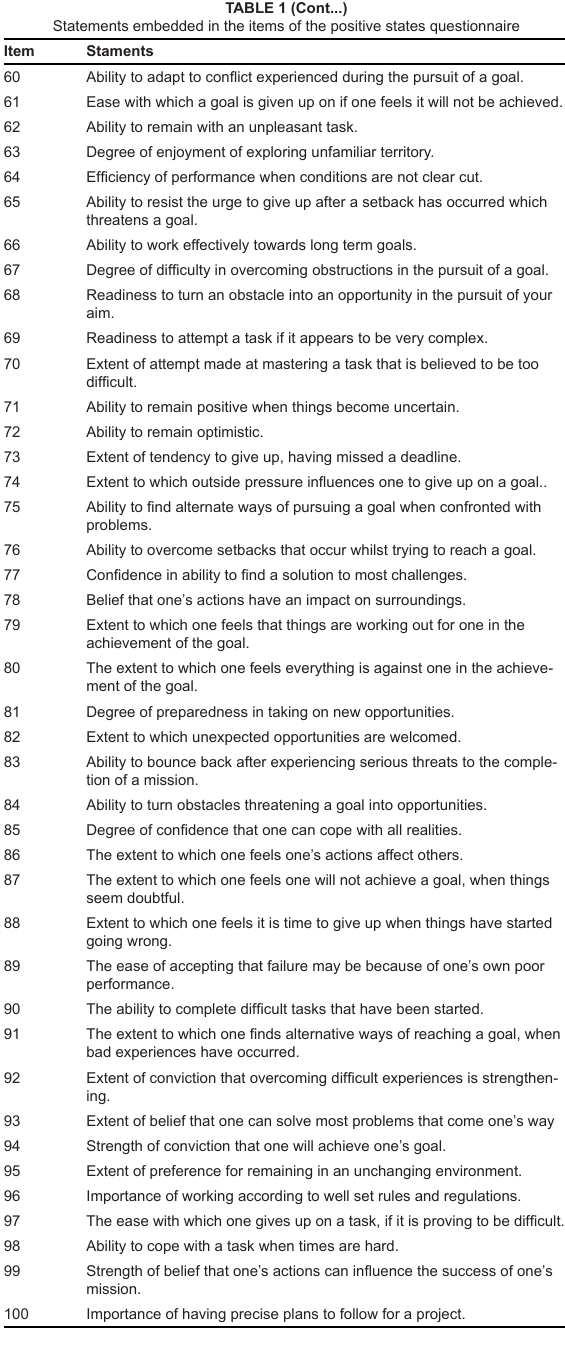
with the Cronbach alpha reliabilities ranging from 0.852 to 0.869. It was decided that all these items would be kept as well and is presented in Table 6. The Cronbach alpha reliability for Factor I was 0.987 and for Factor II 0.867. The overall Cronbach alpha reliability was 0.974. The means for the items of the PSQ ranged from 4.17 to 5.93 and the standard deviations of the items ranged from 1.110 to 1.689. To test the predictive power of the PSQ, multiple regressions were run with EI, EP and the combined entrepreneurship score (EM) as criteria with POST, POSQ and the combined positive states score (POM) as predictors. Firstly, the predictor variables and the criteria were intercorrelated. The matrix of intercorrelations is given in Table 7. From this table it is clear that entrepreneurship Factor I (EI) and entrepreneurship Factor